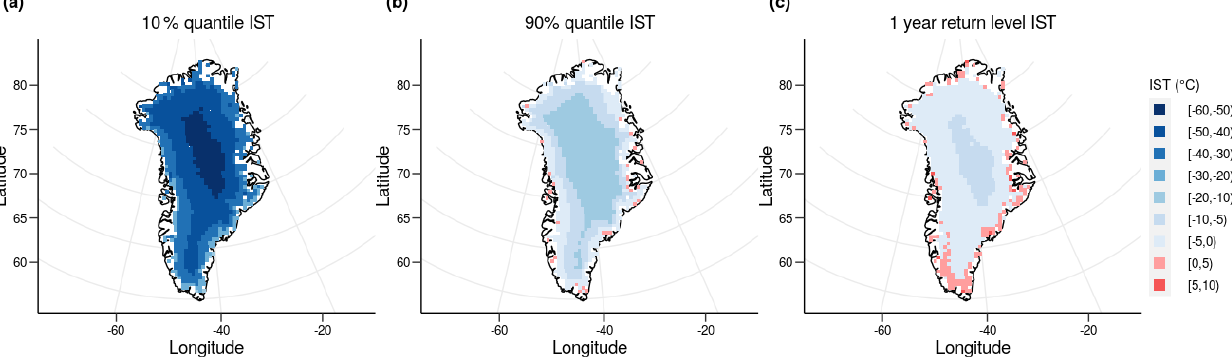
Figure 7. The 10% quantile (a) , 90% quantile (b) , and 1-year return level (c) estimates for MODIS IST data from 2001 to 2019 at 1139 cells. Estimates are calculated from fitted mixture models at each